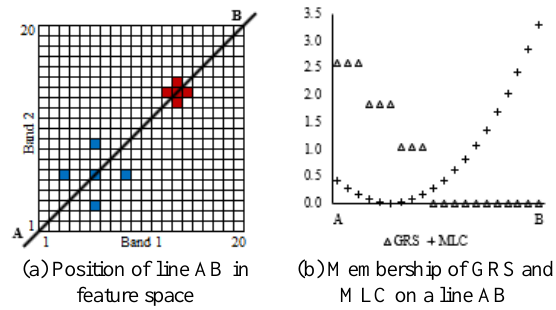
Figure 4. Comparison of class 1 membership between GRS and MLC in Case 1